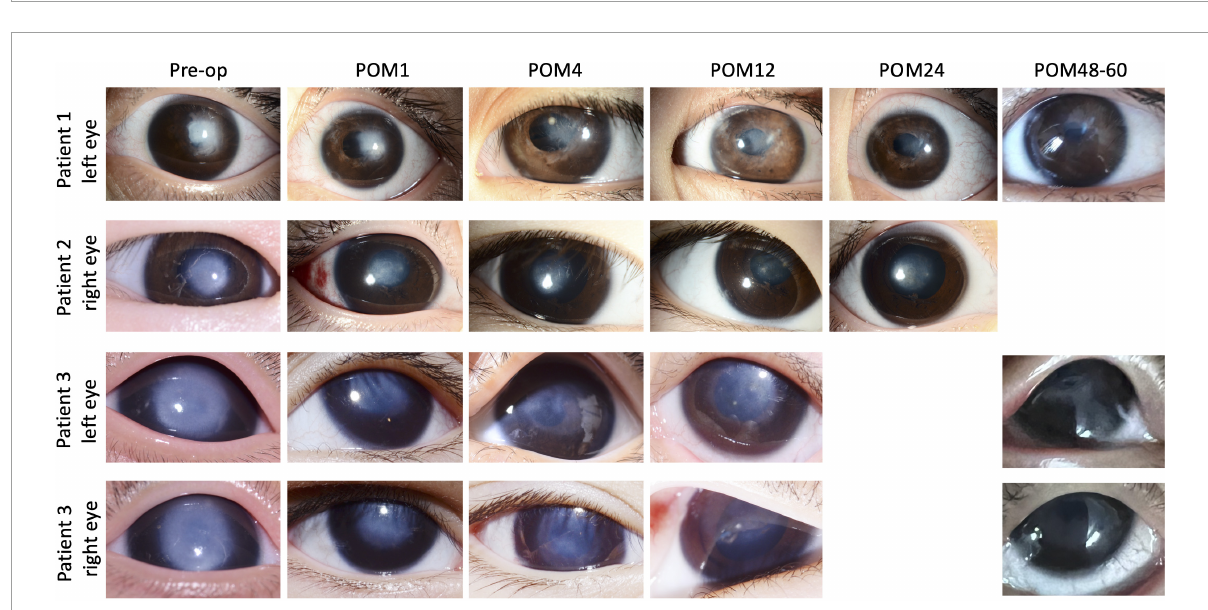
FIGURE2 Picture collage of eyes which underwent selective endothelial removal for the treatment of Peters anomaly. The last reviews for patients 1 and 3 were at the 60th and 48th post-operative month, while the last review with photos being taken for patient 2 was at the 24th post-operative month. Gradual post-operative improvements in the central corneal opacities were seen in all eyes. Pre-op, pre-operative; POM, post-operative